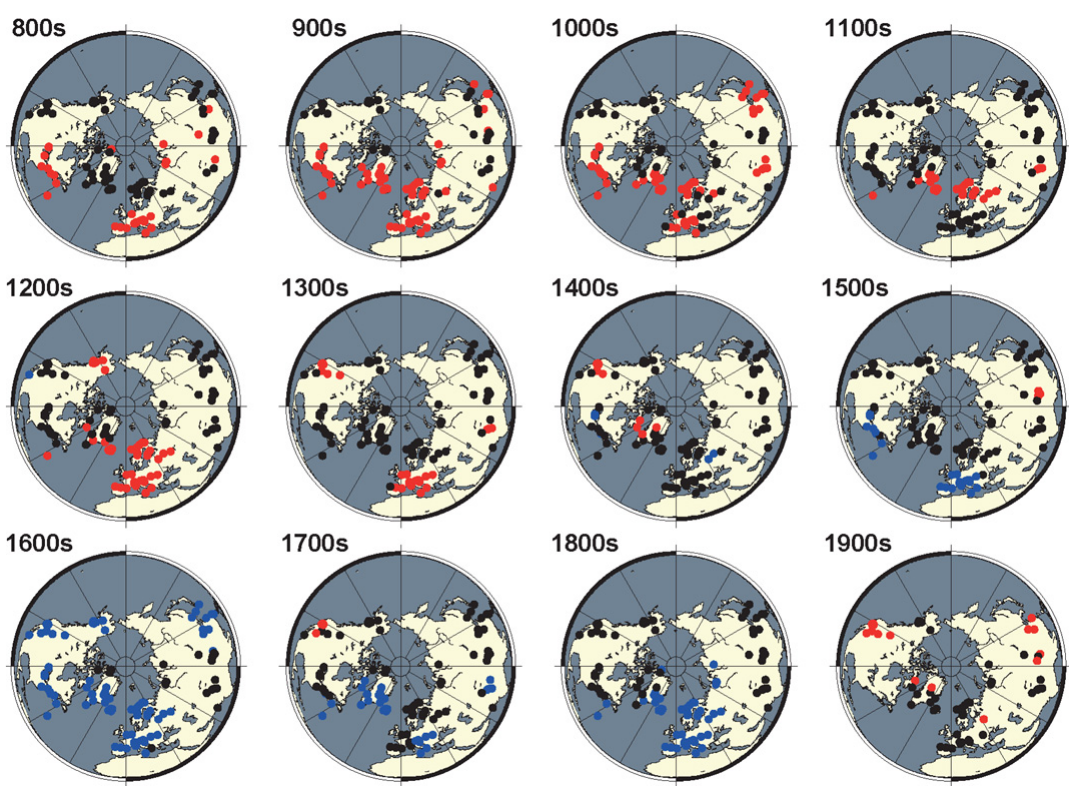
Fig. B1. Sign test of standardized centennial proxy anomalies. Red and blue dots indicate agreement within a search radius centered on each individual proxy location positive or negative, respectively. The search radii of the circles decrease linearly with latitude from 2000km at the equator to 1000km at the pole. Black dots indicate no significant agreement of the sign of